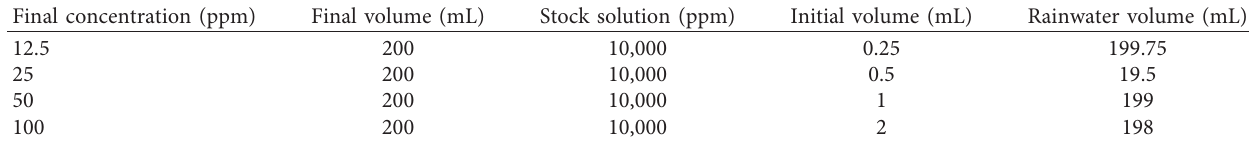
Table 1: Essential oils’ dilution